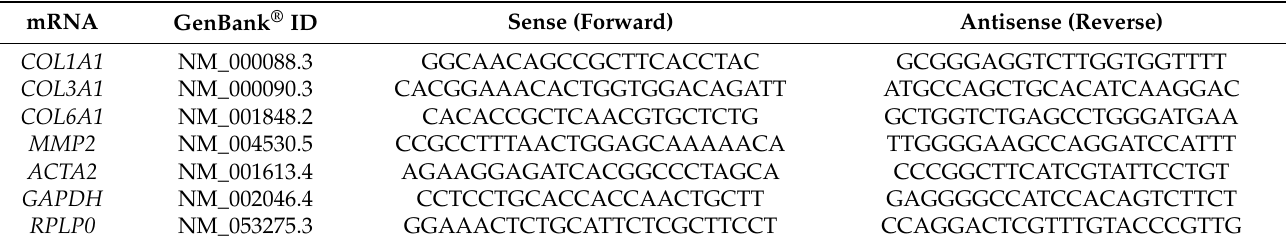
Table 5. Primer sequences for